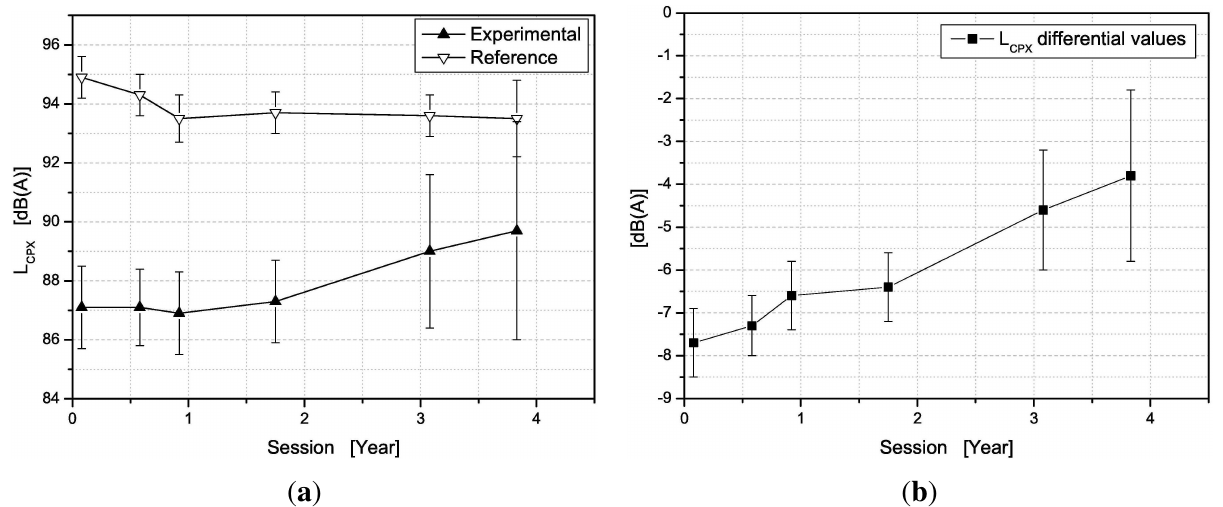
Figure 16. Absolute ( a ) and differential ( b ) values of L (e.g., time, in years) for Micro-draining open grade surface laid in Site 5.